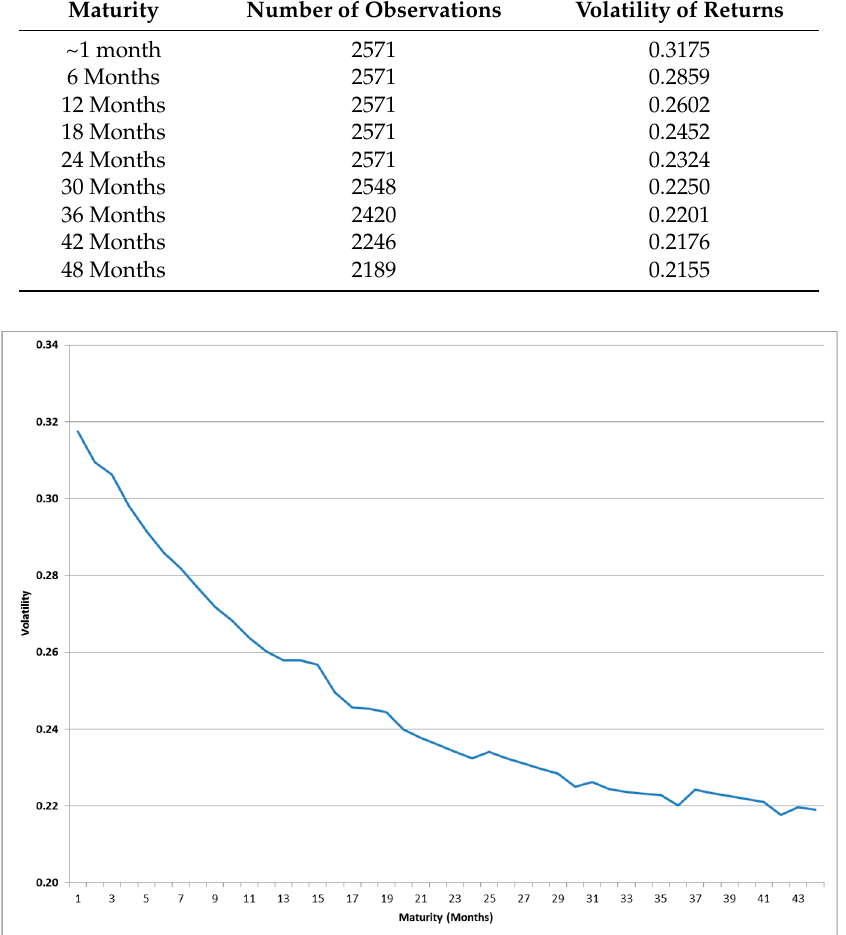
Figure 2. Volatility of returns on contracts with nearest maturity. Source: Our own calculations with ICE futures prices.